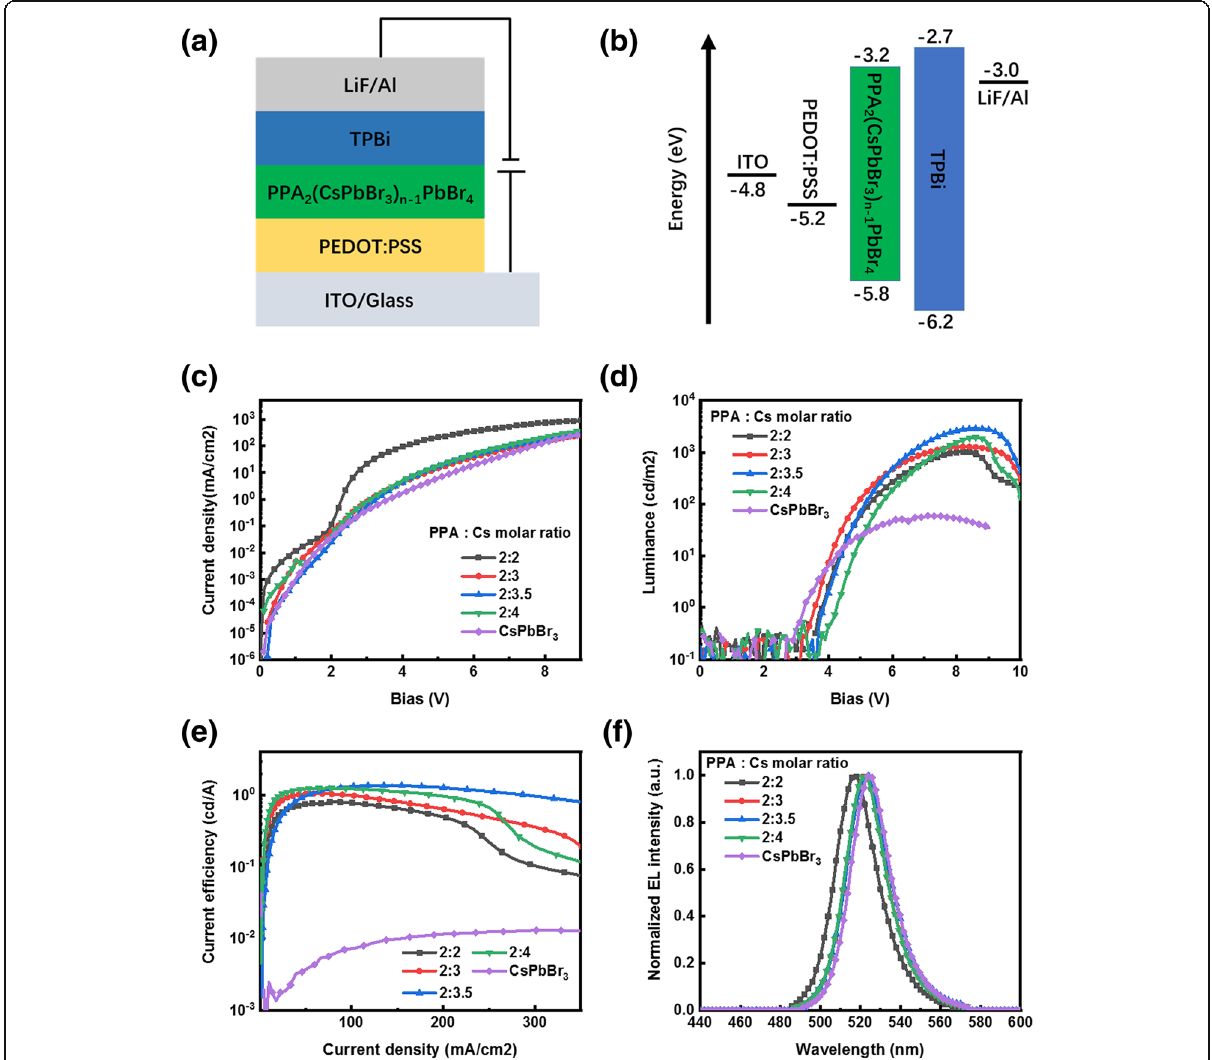
Fig. 6 a Schematic diagram of the device structure and b corresponding energy level for the PeLEDs. c Current density versus voltage curves (J-V), d luminance versus voltage (L-V), and e current efficiency versus voltage (CE-V) characteristic curves of PeLEDs based on different perovskite